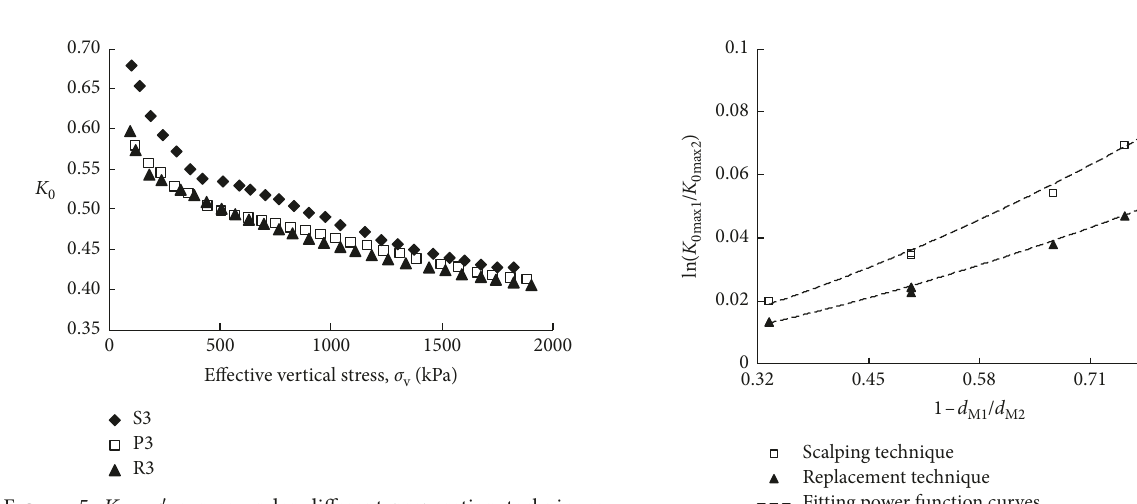
Figure 5: K σ v curves under different preparation techniques 0 ( d M (cid:31) ′ −